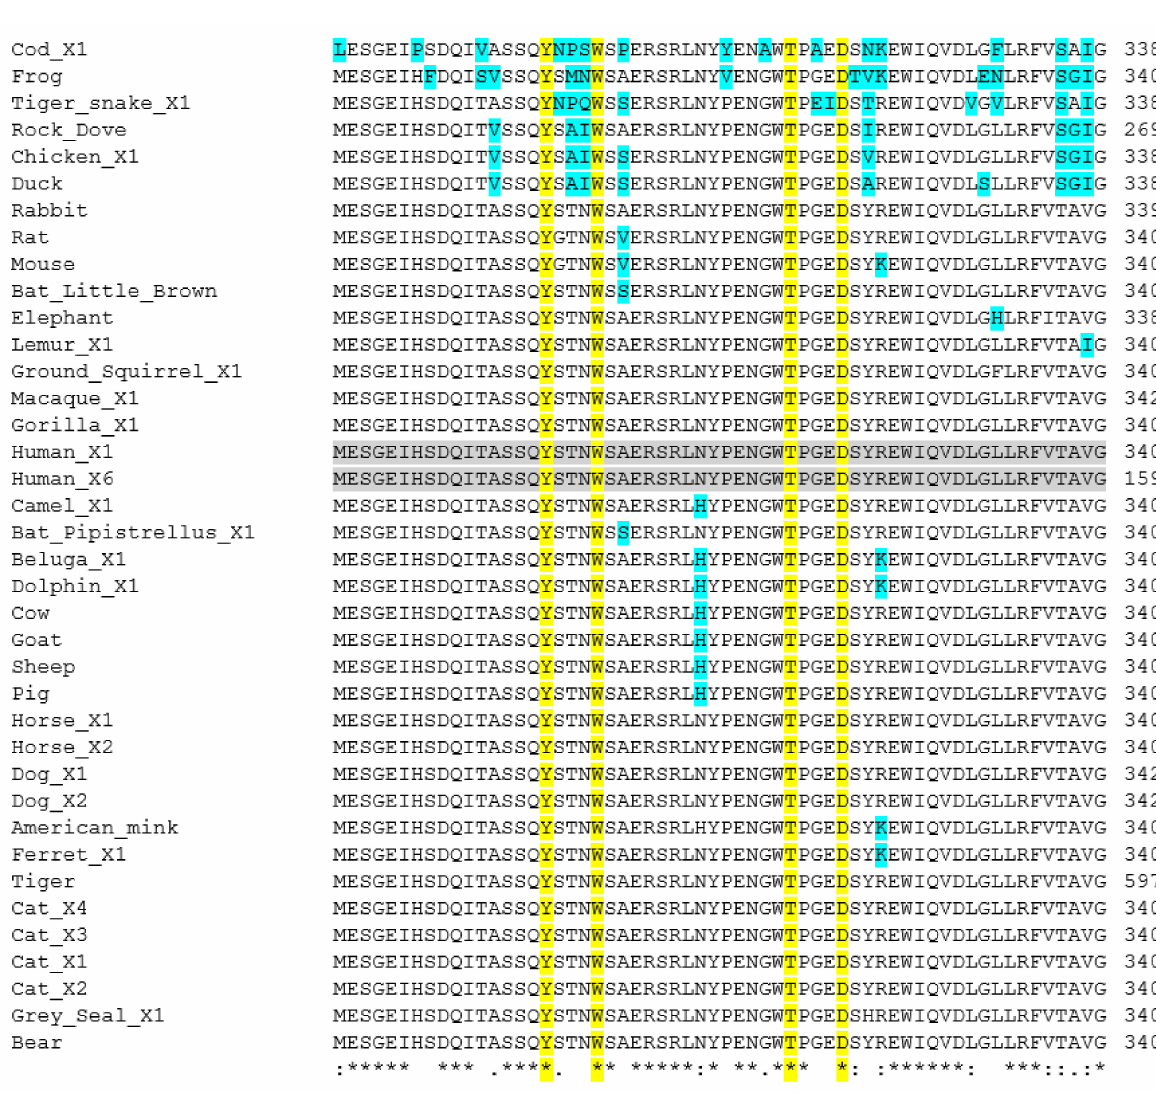
Figure 5. Amino acid sequence alignment of neuropilin-1 polypeptides from a range of animal species: a short section is shown here, whilst the full sequence alignments are shown in Supplementary Figure S3. Accession Numbers of the polypeptide sequences used are given in Table 1. Alignments were carried out using Clustal Omega [45]. The last row shown is the consensus analysis given by the algorithm. Human sequence (variant 2) is highlighted in grey to aid comparison to other sequences. Important amino acids used for interaction with the SARS-CoV-2 viral proteins [14] are highlighted in yellow. Amino acid differences from the human sequence in this region are highlighted in